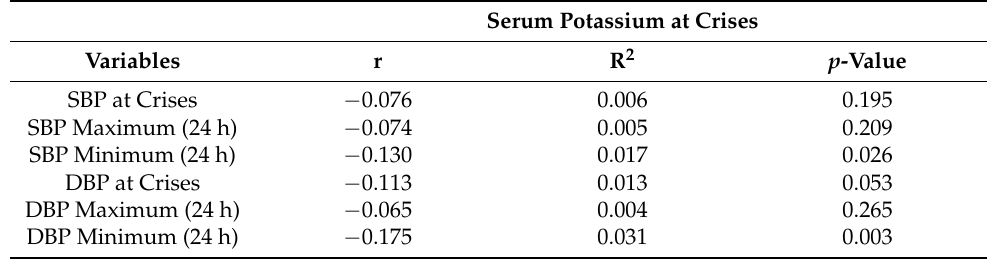
Table 9. Association of serum potassium at crises with SBP and DBP at different time points ( N = 293). Serum Potassium at